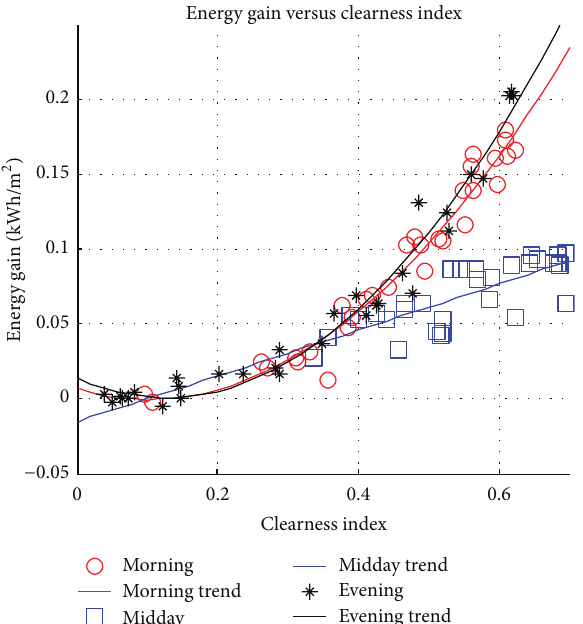
Figure 16: Energy gain of DAST over SSS for 7 cities developed by anisotropic model on 3 segments clearness index.